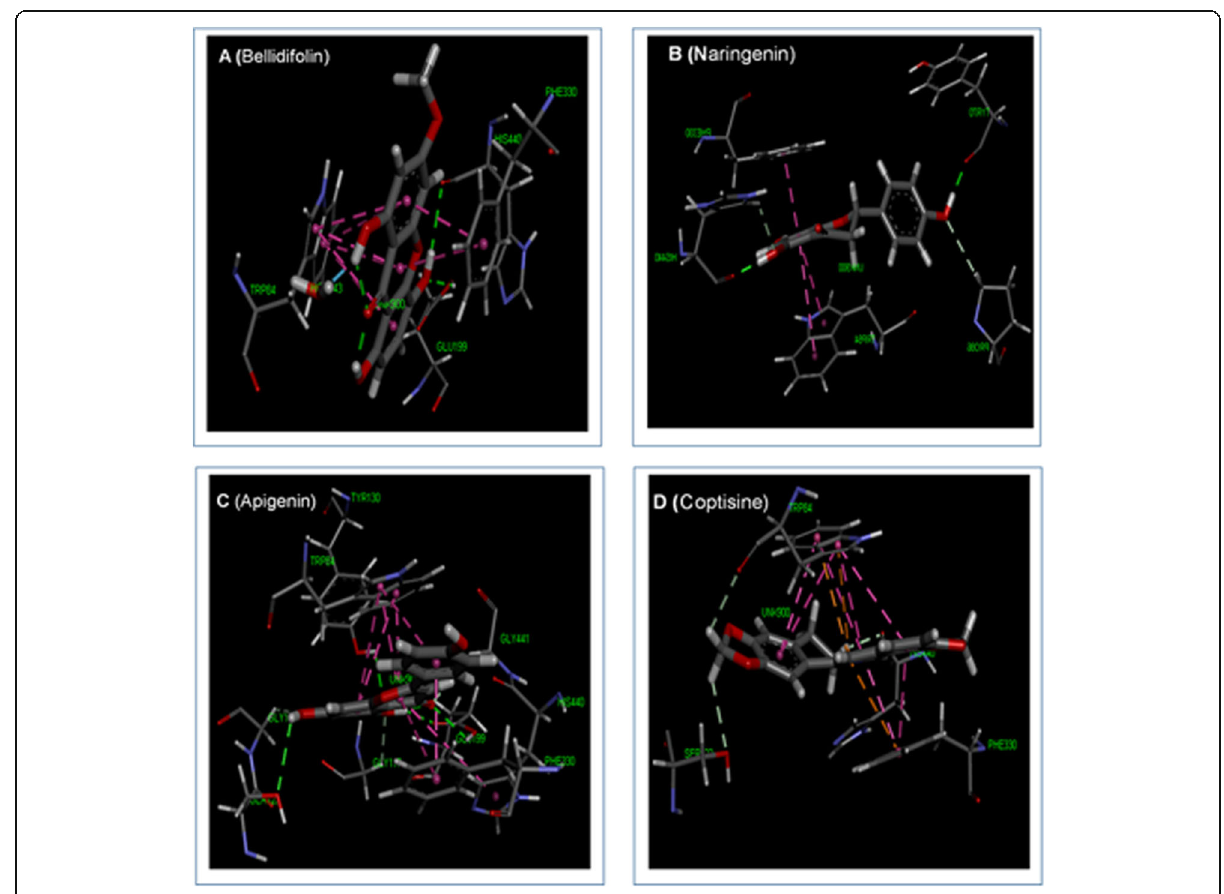
Fig. 2 Figure showing the various types of bonds and amino acids that take part in the interaction between the 4 best selected ligands ( a bellidifolin, b naringenin, c apigenin, d coptisine) and their receptor, AChE. Interacting amino acid residues of target molecule are labeled in the diagram and dotted lines depict the interaction between the ligand and receptor. Green dotted lines — conventional bond; deep pink — Pi-Pi stacked bond; and orange — charge-charge interaction